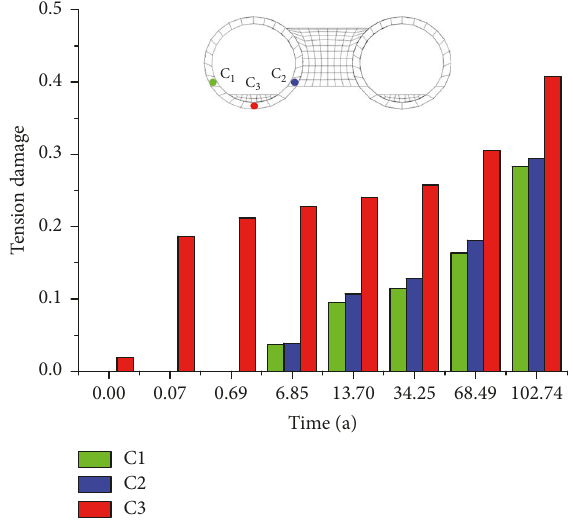
Figure 12: Development trend of maximum principal stress of main tunnel segment.